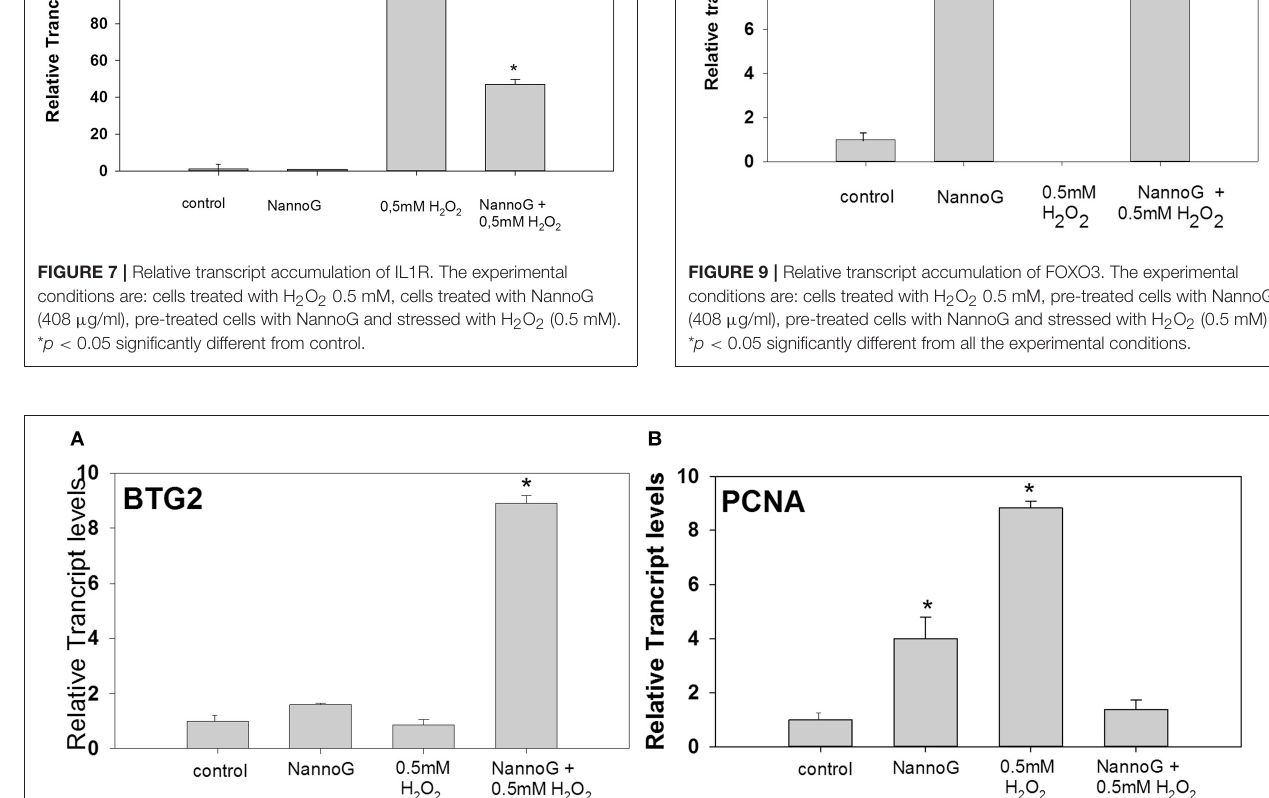
Frontiers in Marine Science |